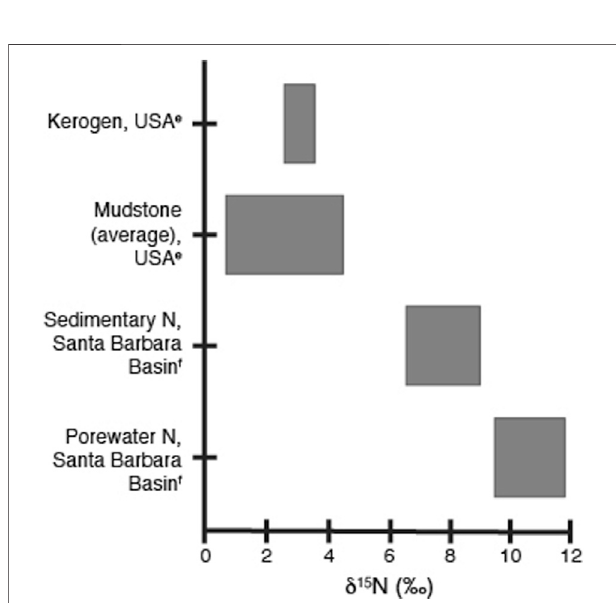
FIGURE 4 | Ranges of measured δ 15 N values for kerogen, mudstone, sediment,andporewatersamples,asreferredtointhetext. Valuesshownare from e Williams et al. 1995 and f Prokopenko et al. 2006; for analytical and sample details, please refer to the original articles.